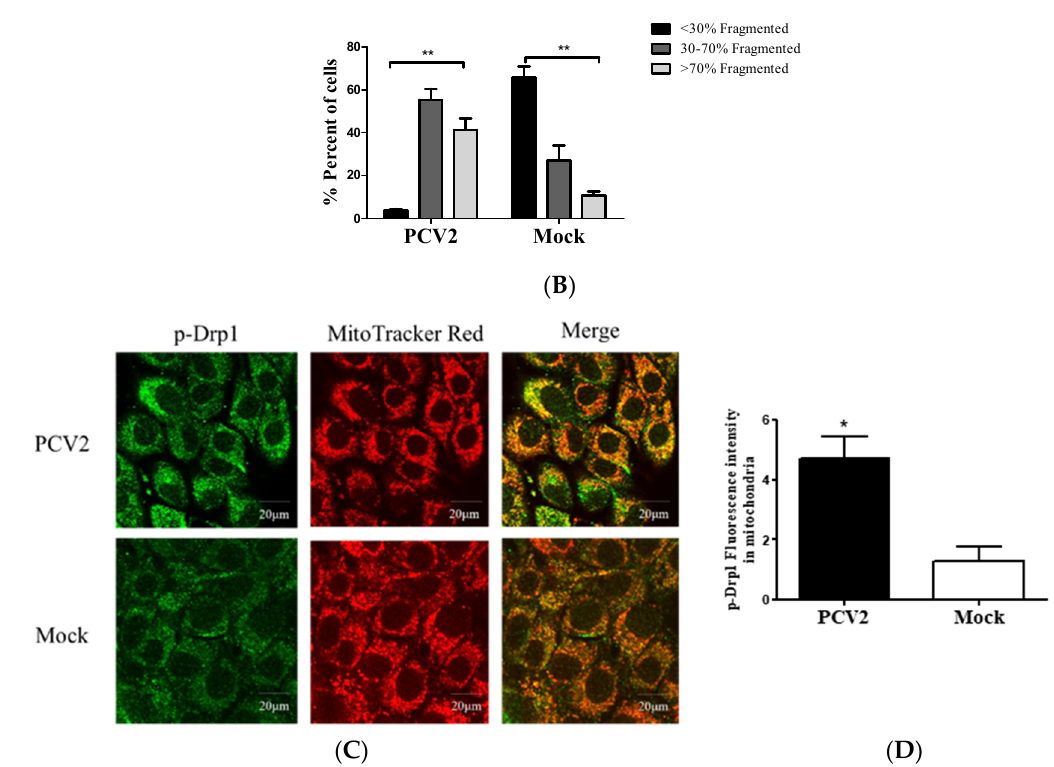
Figure 2. Defects in the mitochondrial tubular networks and mitochondrial translocation of the mitochondrial-fission-related protein Drp1 induced by PCV2. PK-15 cells were infected with PCV2 for 48 h in Petri dishes for confocal microscopy. Mock-infected cells were used as a control. ( A ) Confocal microscopy images showing mitochondrial fragmentation in PCV2-infected cells. At 48 hpi, the cells were stained with MitoTracker (red) (top panels) or immunostained with anti-PCV2 capsid protein antibody (green) (bottom panel). In the magnified images, typical tubular mitochondria in mock-infected cells and fragmented mitochondria in infected cells are shown. ( B ) Quantification of the mitochondrial morphology in (A). Cells were scored as one of the three morphological categories as depicted in the inset. In each group, at least 50 cells were scored. ( C ) The cells were prestained with MitoTracker Red (100 nM) and then immune-stained with anti-phospho-Drp1 (Ser616) (green) at 48 hpi. ( D ) The quantification of the p-Drp1 (Ser616) fluorescence intensity of ( C ) was analyzed using NIH ImageJ software in at least 50 cells of each group. Bar charts ( B , D ) show the mean ± SEM of three independent experiments. * p < 0.05 and ** p < 0.01.